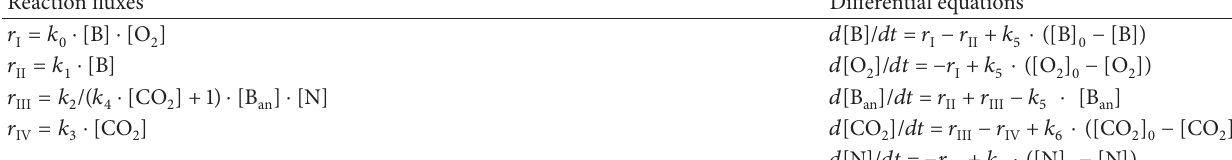
was not considered). The experimentally an ]. an